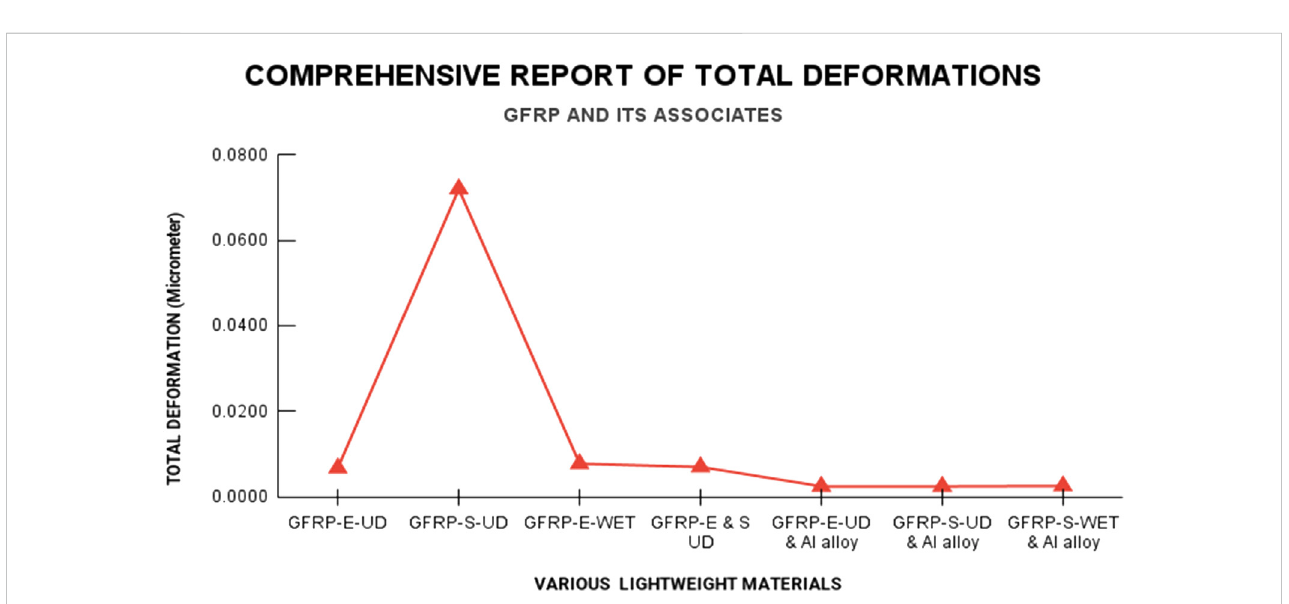
FIGURE 14 Total deformation on half fuselage of RUAV with GFRP and its associate materials.